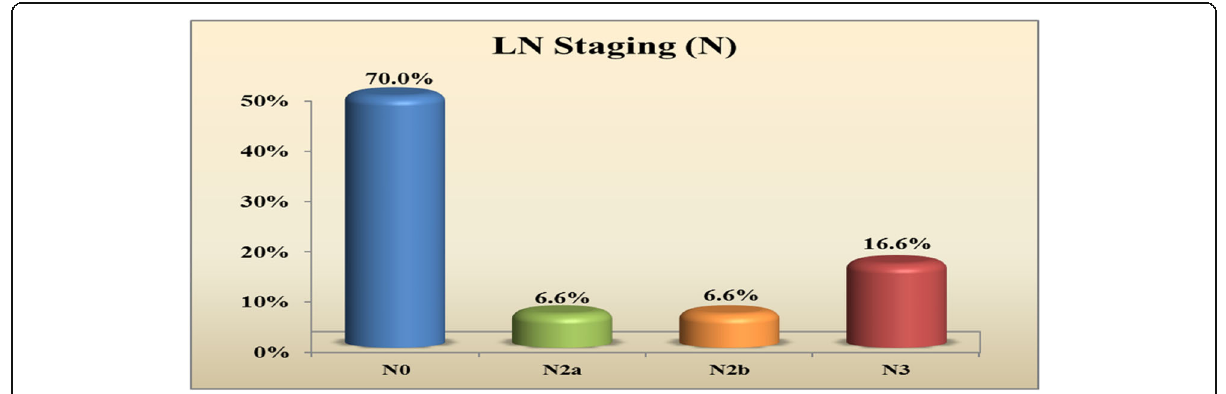
Fig. 2 Lymph nodal staging of the included patients